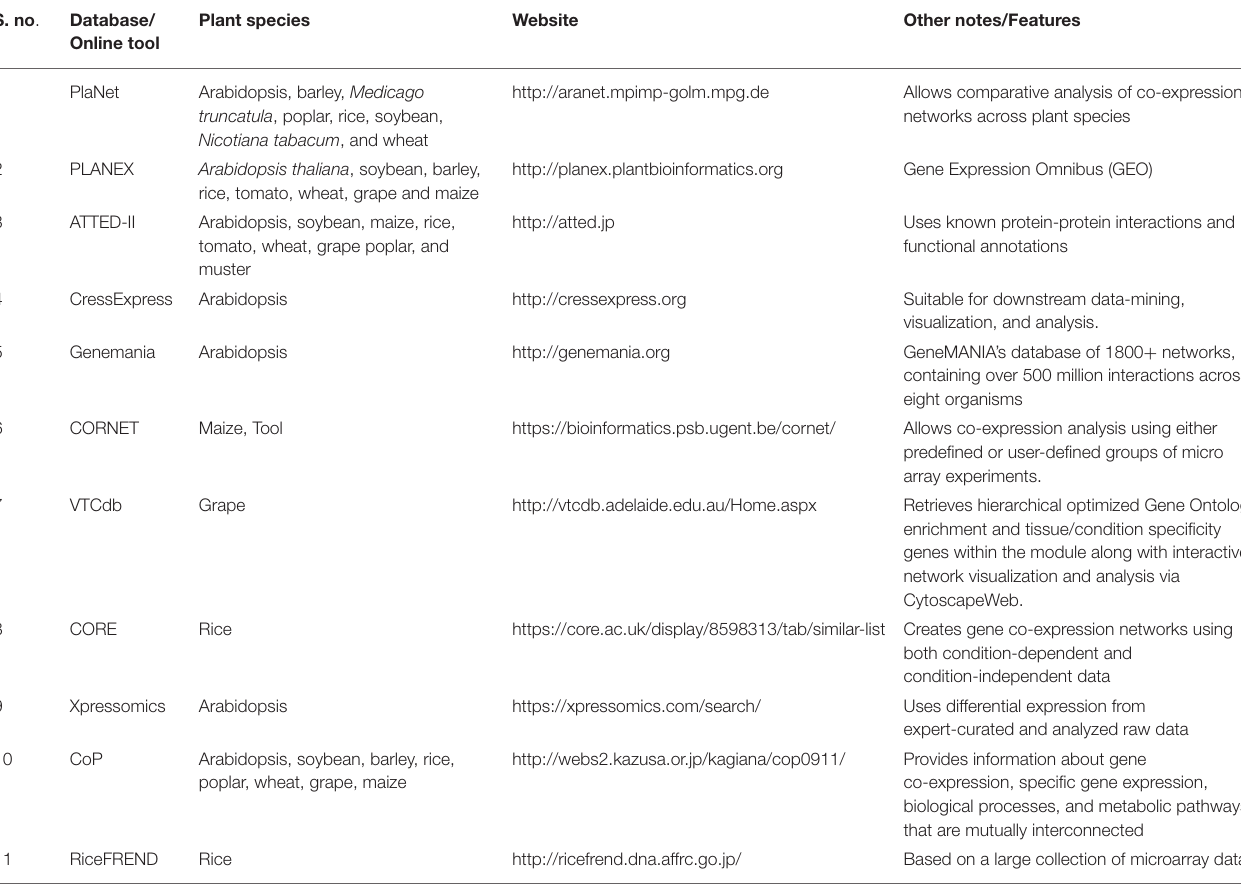
TABLE 2 | Tools available for the development of co-expression network using transcriptomic data from different plant species. S. no